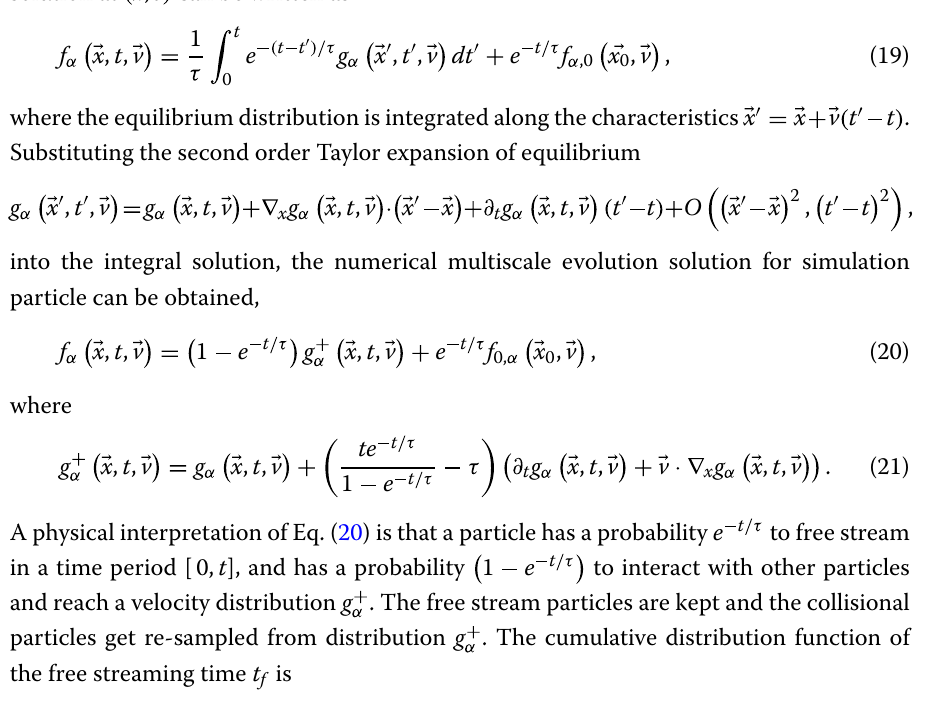
Here m k is the mass of simulation particle P k , which represents a cluster of real gas